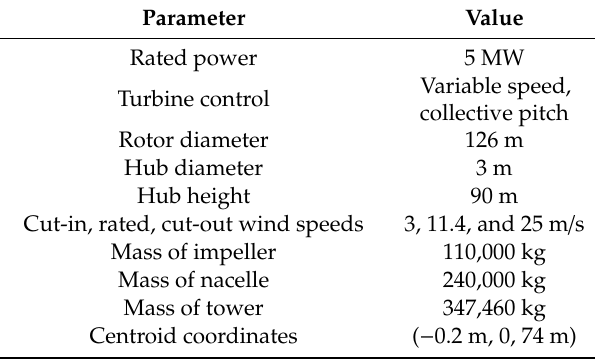
Table 3. Main parameters of the NREL 5 MW wind turbine.